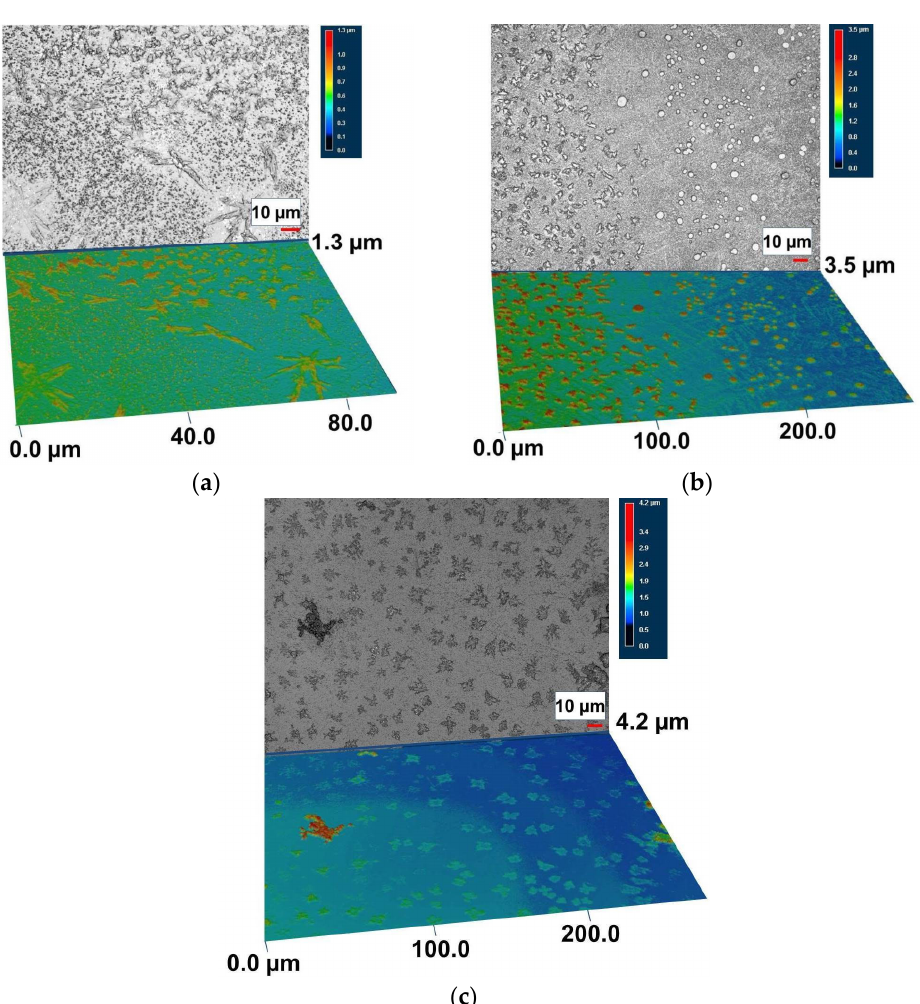
Figure 7. 2D and 3D ( a , b ) images of the surface of condensate films of a hybrid of native BSA 5fr (0.05 mg/mL) + ShC(0.05 mg/mL) ( a ) and fatty acid-free BSA faf (0.05 mg/mL) + ShC(0.05 mg/mL) ( b ). The films consist of particles of various shapes, assembled in short chains ( a ) and separate standing ( b ). Fatty acid-free BSA faf (0.025 mg/mL) + ShC (0.025 mg/mL) ( c